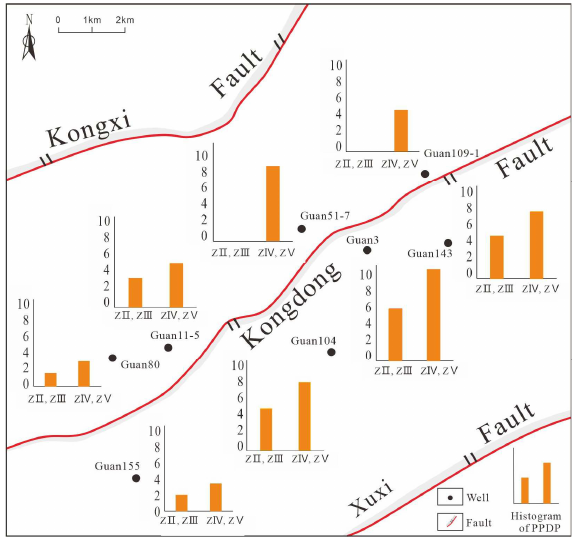
Figure 16. Distribution of PPDP of Ek1 member in the Wang Guantun Area.